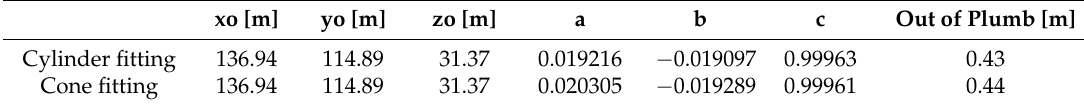
Table 2. Fitting the whole point cloud with a cylinder and a cone primitive.